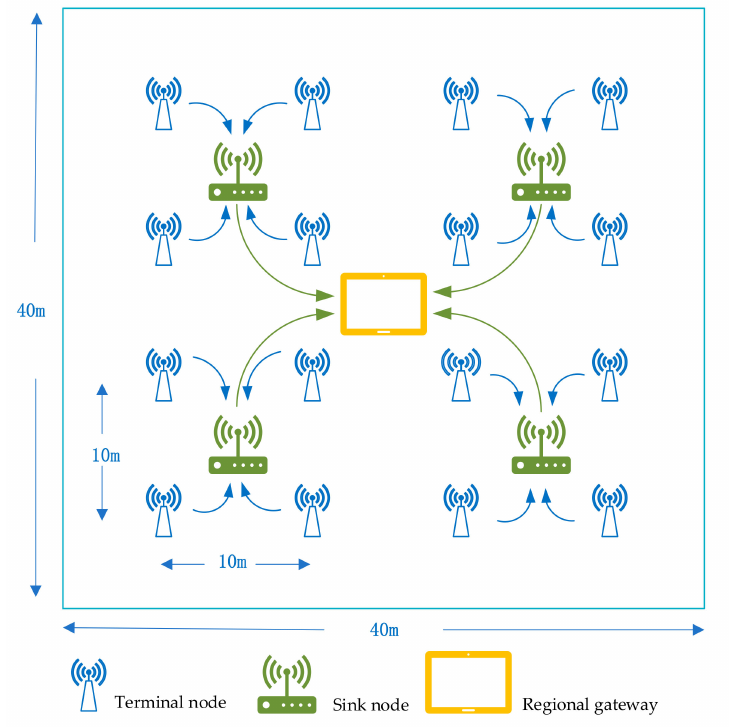
Figure 2. Greenhouse WSNs system topology